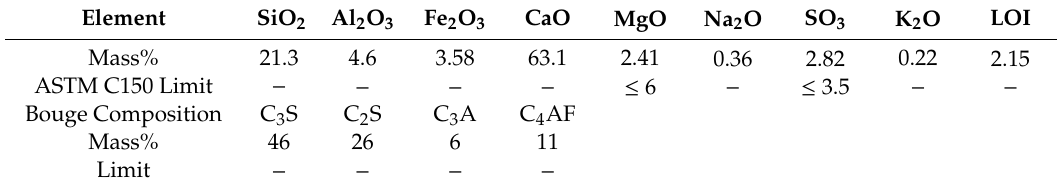
Table 1. Chemical composition of used cement [29].